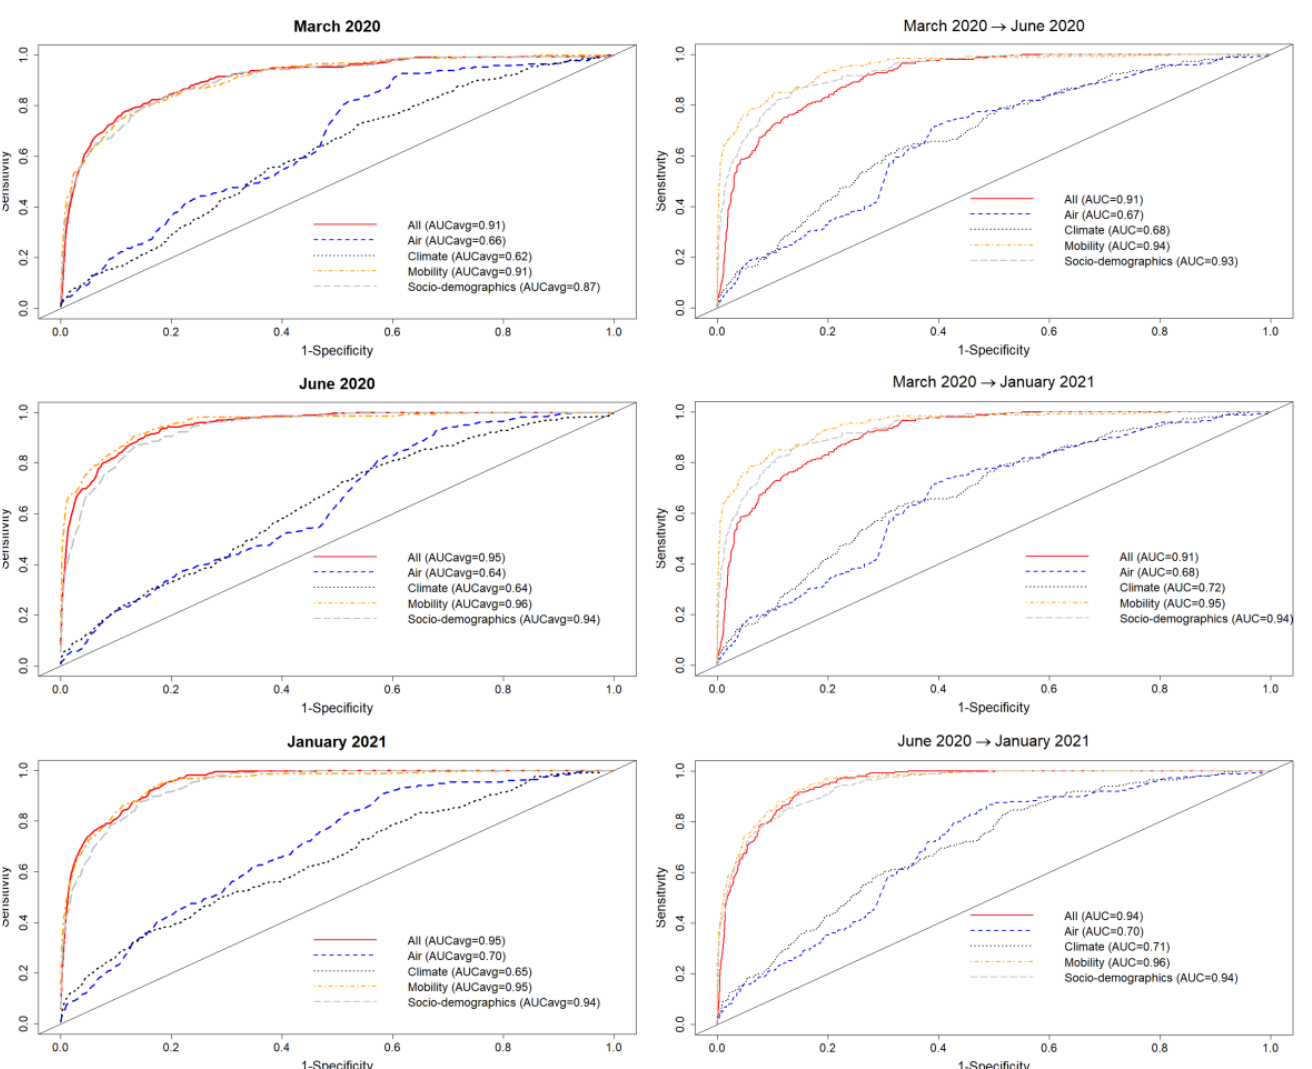
Figure 1. Left: Performance for five different SDMs for the class—top 10% of municipalities with the highest number of cases—according to the habitat variable group considered (mobility, socio- demographics, air, climate, and all) for three different months of the pandemic. Five different train-test 70%–30% splits were considered for each month; Right: Performance for five different SDMs for the class—top 10% of municipalities with the highest number of cases—according to the habitat variable group considered (mobility, socio-demographics, air, climate, and all) using a model trained on one month and tested on a future